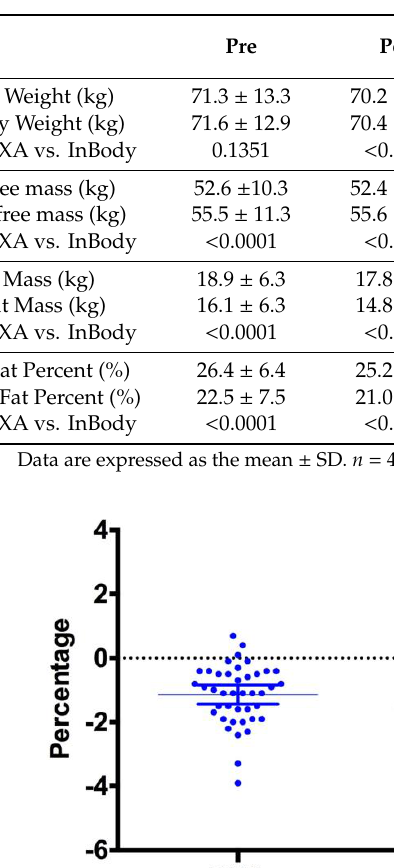
Table 3. Body Composition.